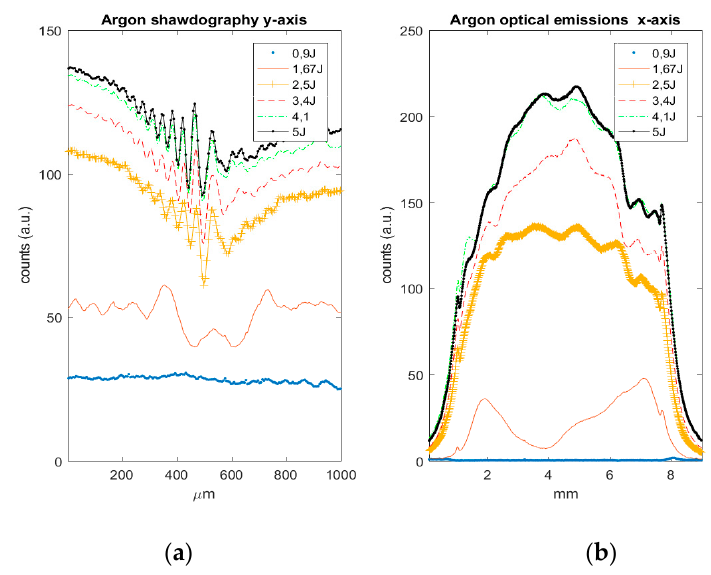
Figure 7. Experimental measurements obtained with an Ar target at 51.2 bar for different laser energy values; (a) Shadowgraphy profiles of the elongated plasma structures in the y-axis, averaged over 1 mm in the x-axis; (b) top-view profiles of the optical plasma emission along the x-axis, averaged along the entire z-axis.